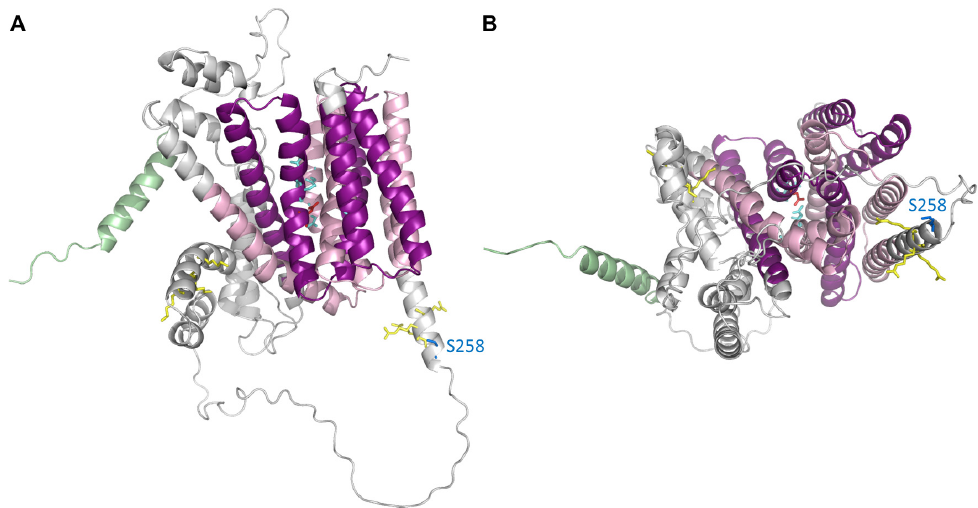
Figure 1. Putative three-dimensional structure of human NCLX (UniProtKB accession number Q6J4K2) predicted using AlfaFold [36]. The pdb file (AF-Q6J4K2-F1-model_v1) was downloaded from the AlphaFold Protein Structure Database (https://alphafold.ebi.ac.uk/ accessed on 05 November 2021) and graphics were prepared using PyMOL v.2.1.0. ( A ) Side view, ( B ) bottom view. Putative mitochondria transit peptide and two sodium/calcium exchanger membrane regions are shown in green and pale and dark pink, respectively. Putative protein kinase A (PKA) phosphorylation site, S258 [39], is shown as blue sticks. Putative amino acids rendering Li + selectivity, Na + selectivity [34], and those sensitive to ∆Ψ depolarization [38] are shown as light blue, red, and yellow sticks, respectively.